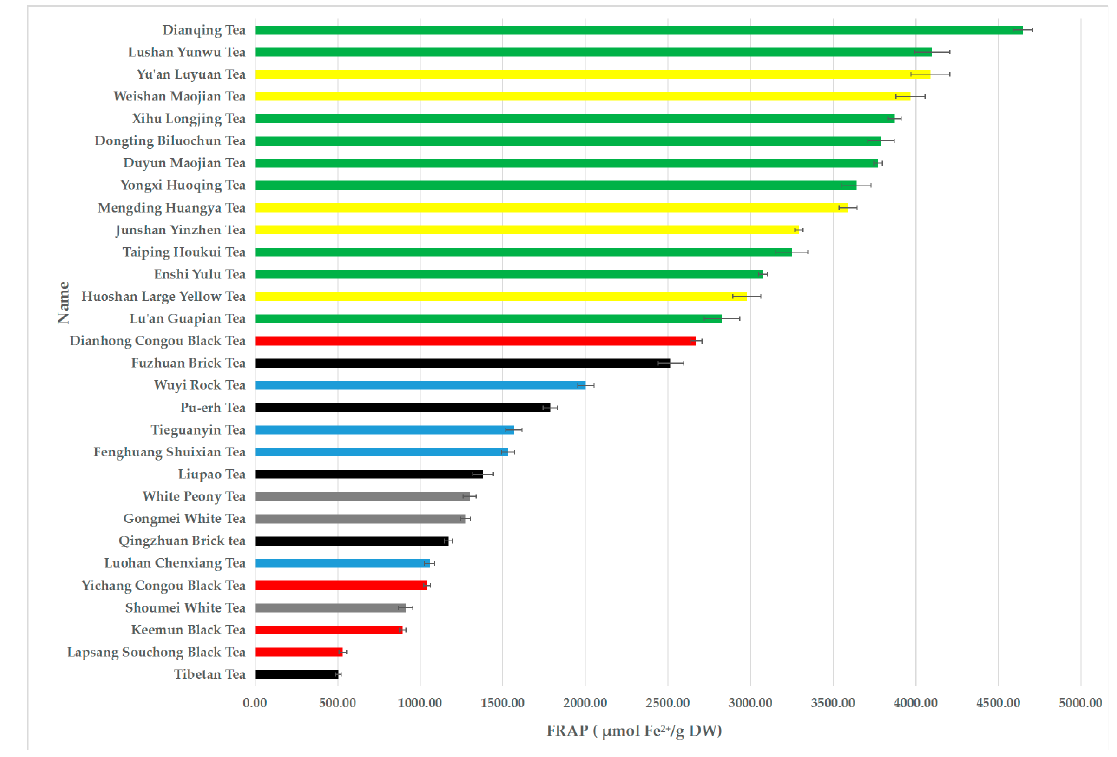
Figure 1. The FRAP values of 30 teas.